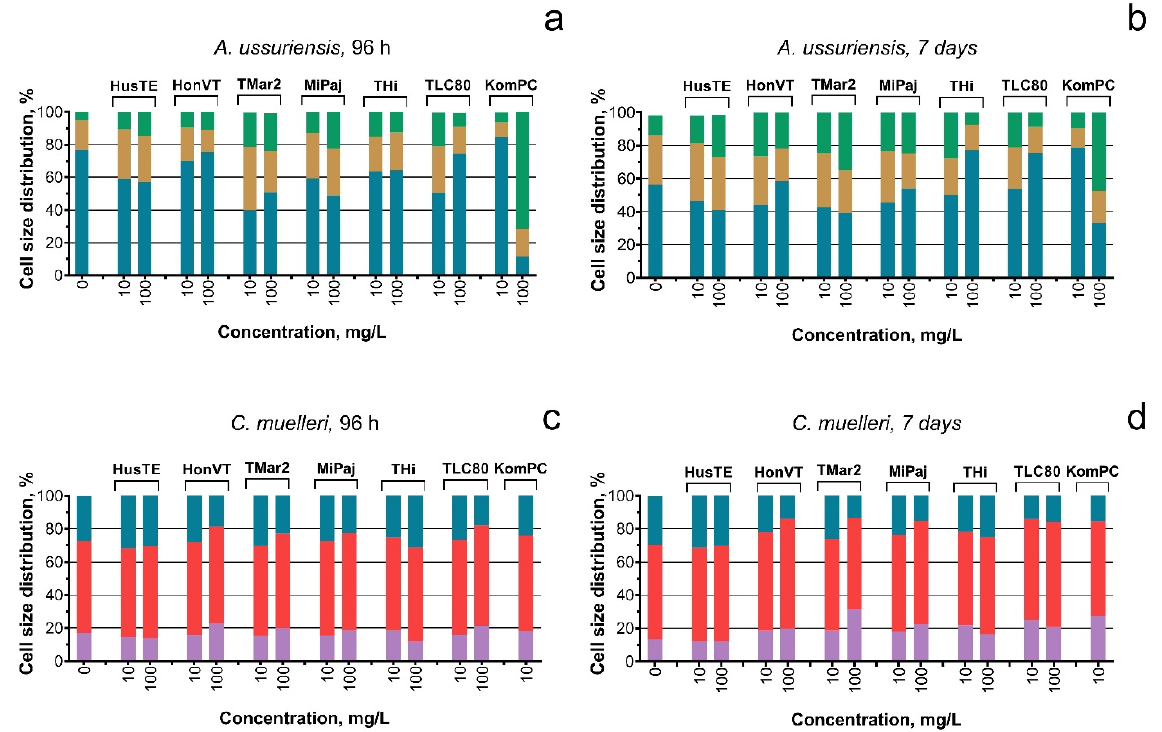
Figure 4. The size distribution of microalgae cells exposed to the VEPs: ( a ) A. ussuriensis after 96 h of exposure; ( b ) A. ussuriensis after 7 days of exposure; ( c ) C. muelleri after 96 h of exposure; ( d ) C. muelleri after 7 days of the exposure. The results for the measurement with C. muelleri exposed to 100 mg/L of the KomPC sample are not represented in the graph because most C. muelleri cells were dead during the measurement because of the high toxicity of this sample. The concen- tration of 1 mg/L of all the tested samples had no significant effect on the size of microalgae cells (not represented on the graph).